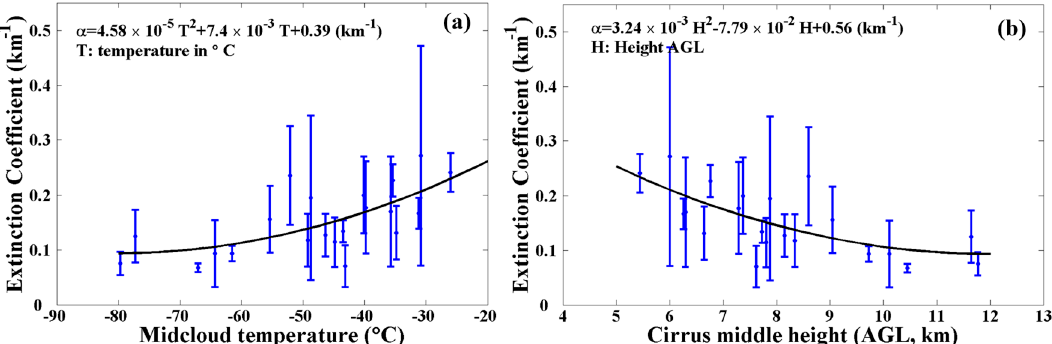
Figure 6. ( a ) Scatter diagram of extinction coefficient and midcloud temperature, ( b ) Scatter diagram of extinction coefficient and cirrus middle height. The black lines indicate the corresponding fitting curves.